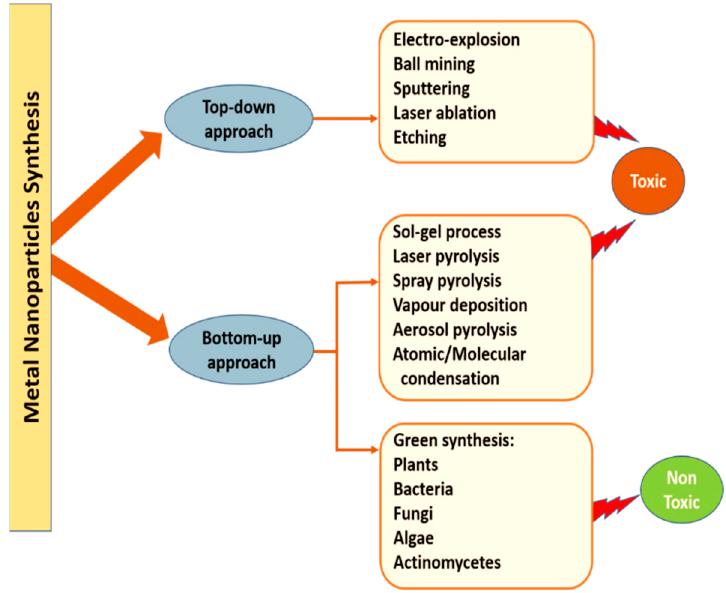
Figure 3. Different approaches of synthesis of metal NPs.